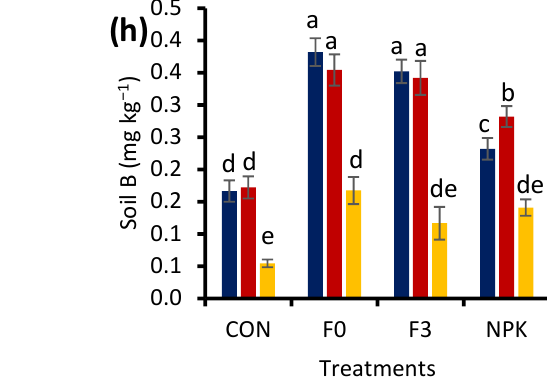
373 377 379 380 381